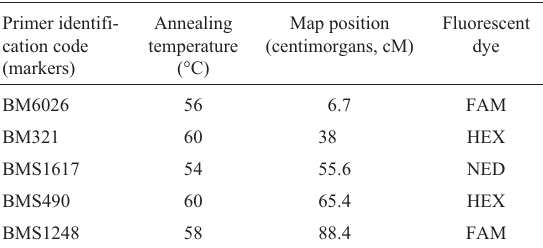
Table 1 - Primer identification code, annealing temperature, reference map position (http://www.marc.usda.gov) and fluorescent dye used in the experiments. Primer identifi- cation